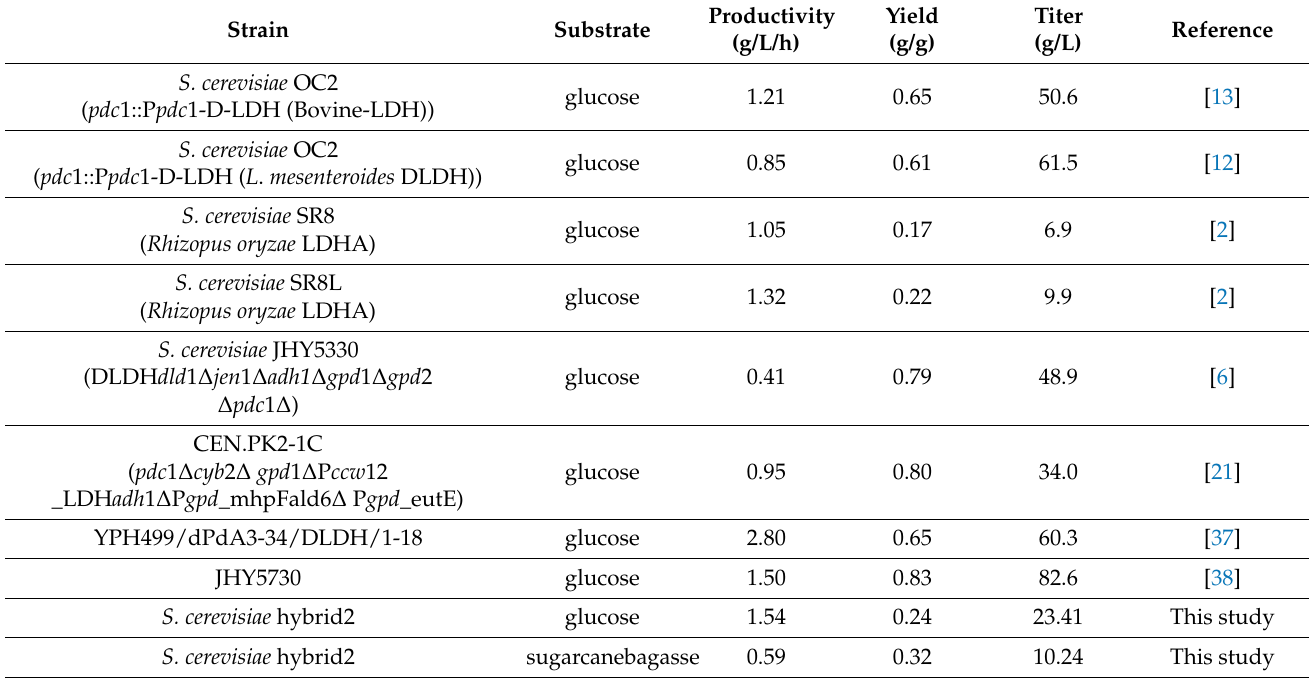
Table 4. Comparison of genetically engineered Saccharomyces cerevisiae for lactic acid production. Strain Substrate